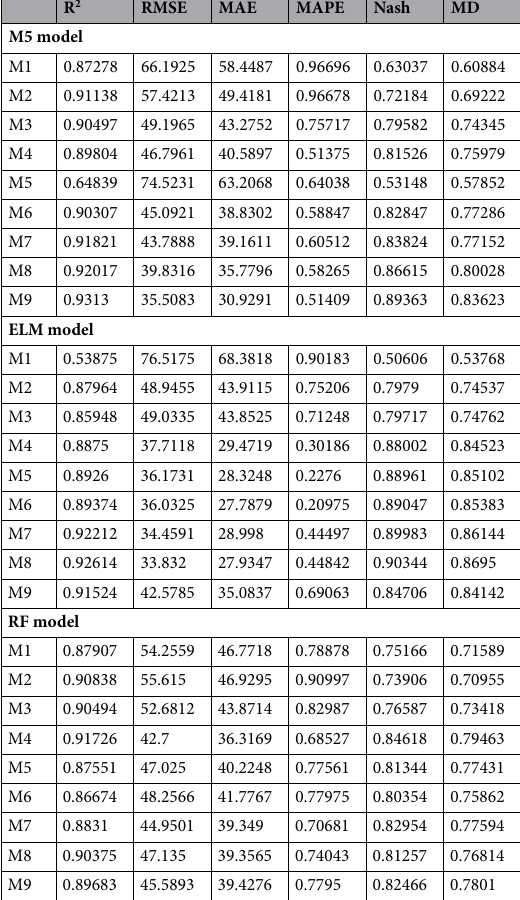
Table 5. Only M5-M5 model revealed poor reliability in shear estimation which has gained R 2 = 0.6484 and high maximum residual error as depicted in Figs. 4 and 8. For ELM model, the least RMSE is attained by ELM-M8